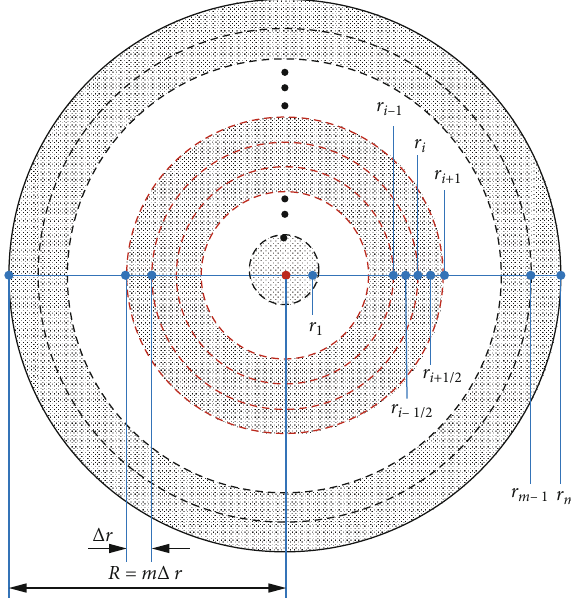
Figure 3: The numerical di ff erence of a single